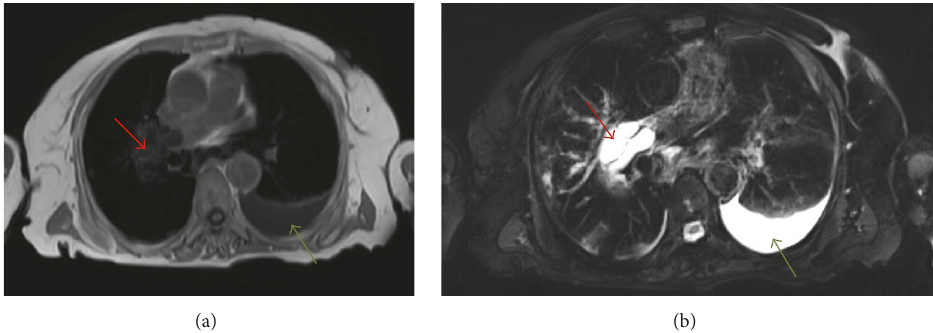
Figure 4: (a-b) Axial T1 and T2 weighted images show hydatid cyst (red arrows) in the right main pulmonary artery and small pleural effusions on the left side (green arrows).